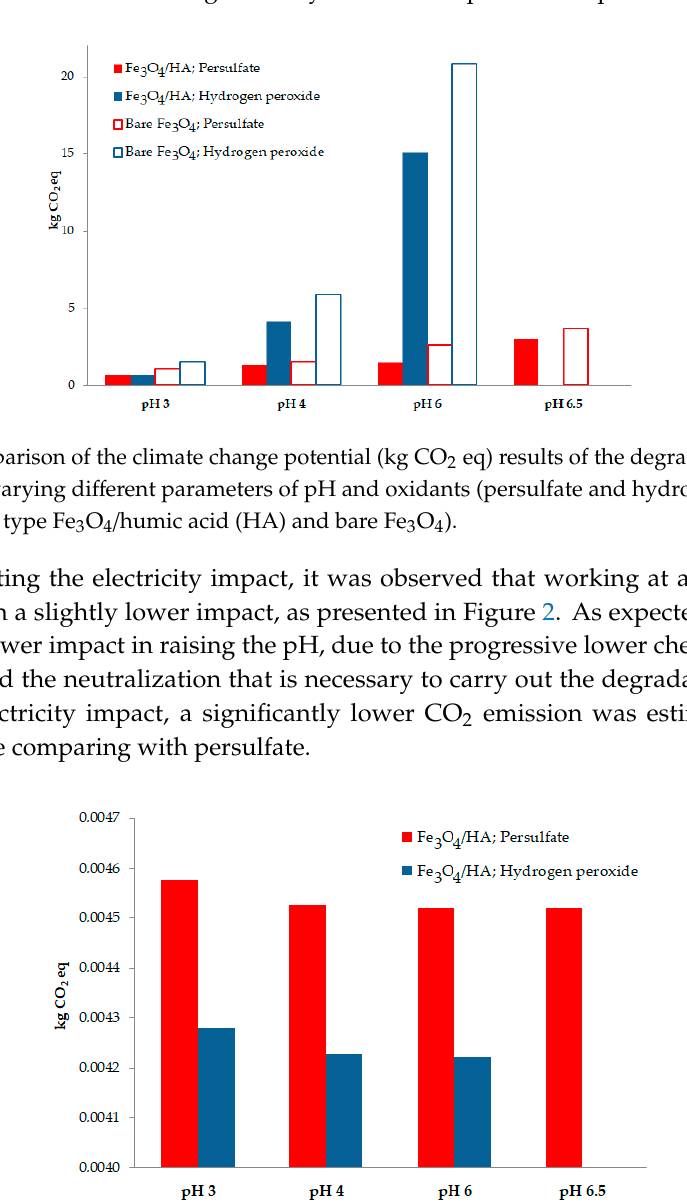
Figure 2. Comparison of the climate change potential (kg CO 2 eq) results of the degradation processes neglecting the electricity input. The bars report the results obtained by varying two parameters, the pH and oxidant (persulfate and hydrogen peroxide (1.0 mM)) in the presence of Fe 3 O 4 /HA (100 mg/L).